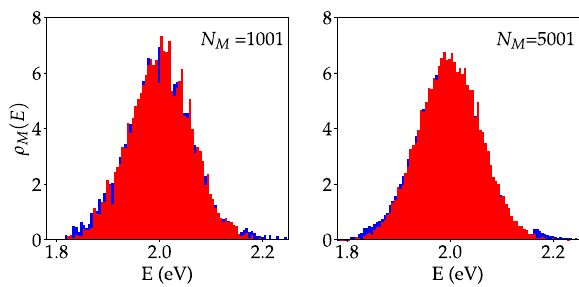
Fig. 2 Ensemble limit of local molecular density of states in polaritonic wire. Local molecular density of states obtained from fi ve realizations of a molecular system in free space (red) and under strong coupling (blue) to a photonic wire ( N C = N M ) with E M − E C (0) = 0 (zero detuning), N M = 1001 and 5001, Ω R = 0.3eV, σ / Ω R = 0.2, σ μ = 0.05 μ 0 , and f = 0.1 in both cases. Other parameters are listed in the text (See Thermodynamic limit